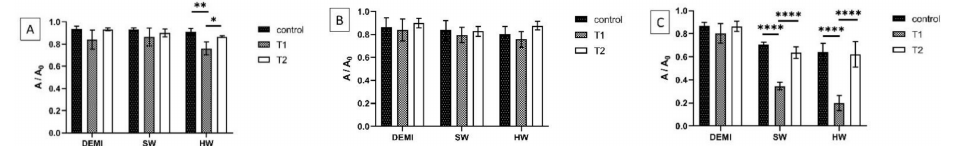
Figure 5. Photostability of TMPyP3 ( A ), TMPyP3-CH 3 ( B ), and TMPyP3-C 17 H 35 ( C ) measured in DEMI, SW, and HW. T1 represents a ratio of the absorbance recorded on the fifth and on the first day (A/A 0 ) of 10 µ M PS solution that was irradiated for 10 min every 24 h for 5 days (411 nm; total light dose 33 J/cm 2 ), while T2 represents A/A 0 after a 5-day-long experiment where each PS was irradiated for 10 min only the first day (411 nm; total light dose 6.6 J/cm 2 ). Control represents PSs tested under the same conditions, protected from light. Data represent an average of triplicate measurements ± standard deviation (SD); **** p < 0.0001, ** 0.001 < p < 0.01, * 0.01 < p <